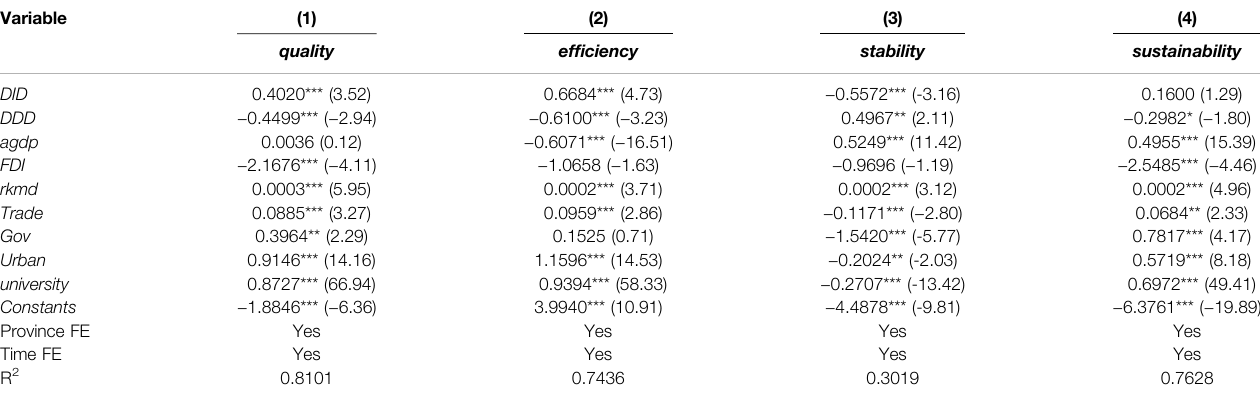
TABLE 7 | Results of the internal capacity heterogeneity analysis. Variable